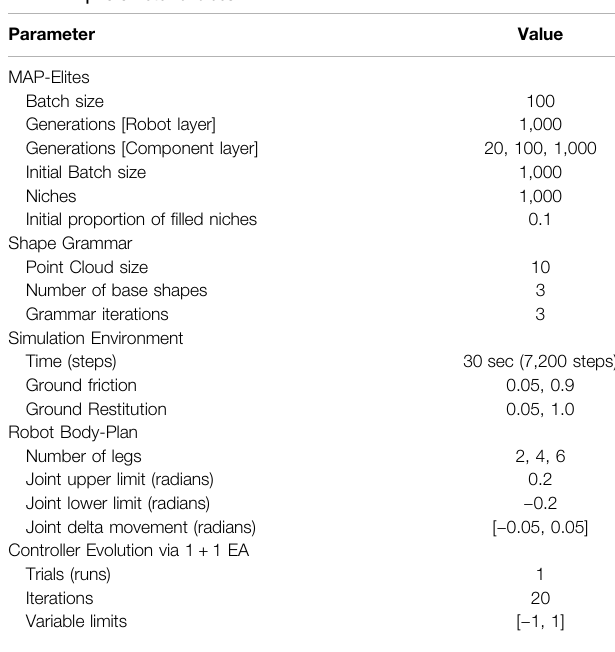
TABLE 1 | Parameter